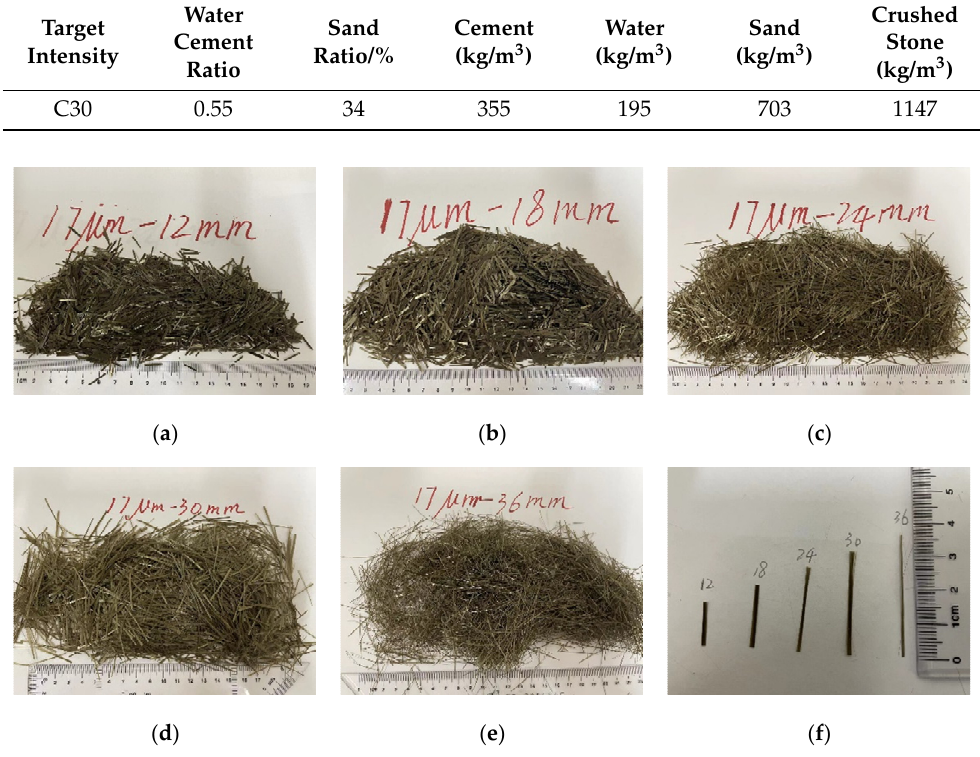
Table 1. The mixed proportion of the concrete. Table 2. The physical and mechanical properties of the basalt fiber.